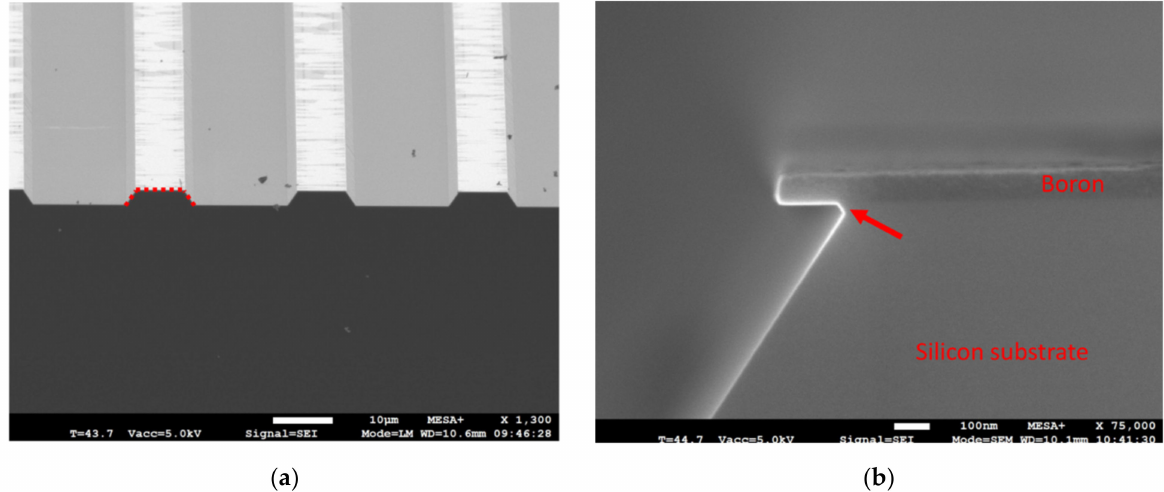
Figure 5. SEM images of a 52 nm thick boron PECVD film (350 ◦ C, 60 W RF, 50 sccm B 2 H 6 precursor, 1800 mTorr) used as hard mask for selective wet chemical etching of silicon: ( a ) SEM image showing 8 µ m wide boron lines with a 26 µ m pitch; the exposed silicon (Si) was etched by TMAH, resulting in trenches bound by <111> crystalline Si-planes (a red line is added as guide to the eye); ( b ) silicon was also etched underneath the boron film hard mask; the small angular deviation of the silicon <111> crystal planes directly underneath the boron film (indicated with a red arrow) is the result of unwanted plasma etching of silicon during structuring of the boron film with reactive ion